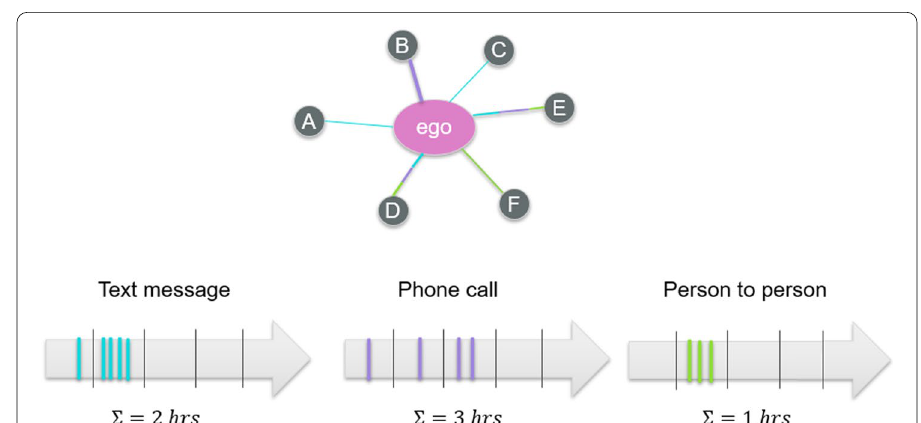
Fig. 1 Node E has 2 h text messages, 3 h phone call, and 1 h in-person interactions. These interactions